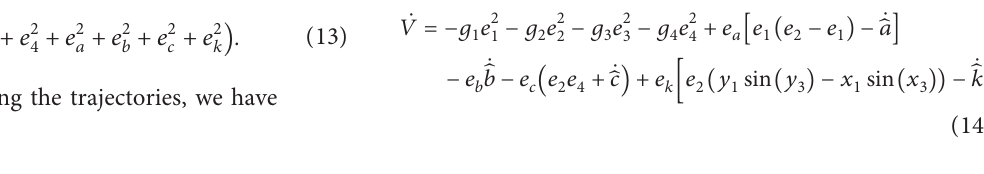
Figure 21: Time evolution of the synchronization errors e the activation of the adaptive control law.